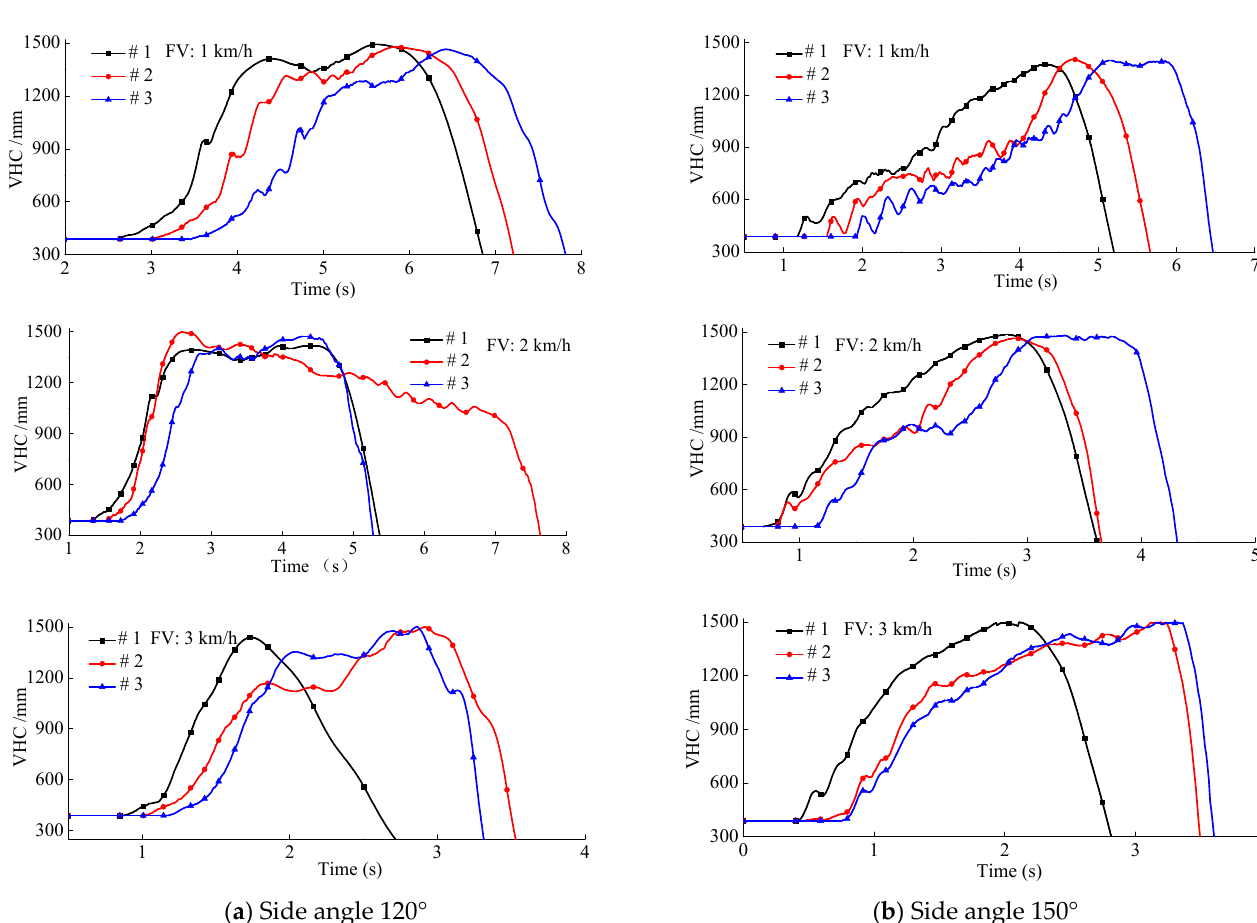
Figure 10. Change of VHC in side LS.